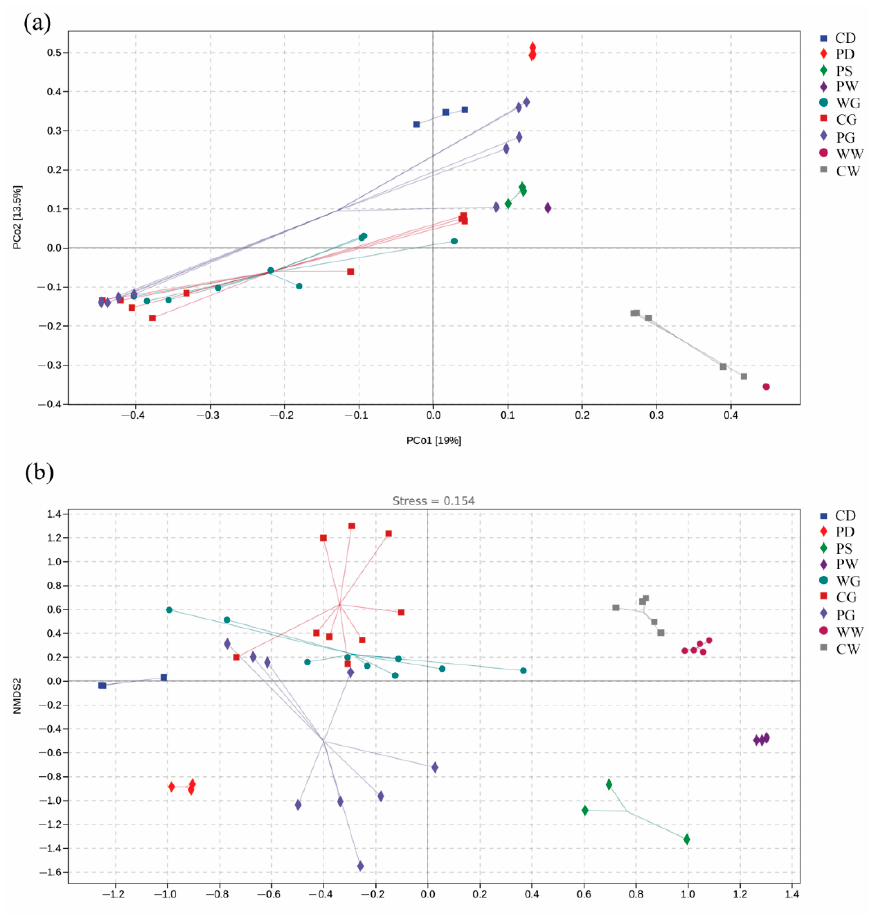
Figure 3. Distributions of the microbial communities of the different groups. ( a ) principal coordinates analysis (PCoA); ( b ) nonmetric multidimensional scaling (NMDS) analysis.